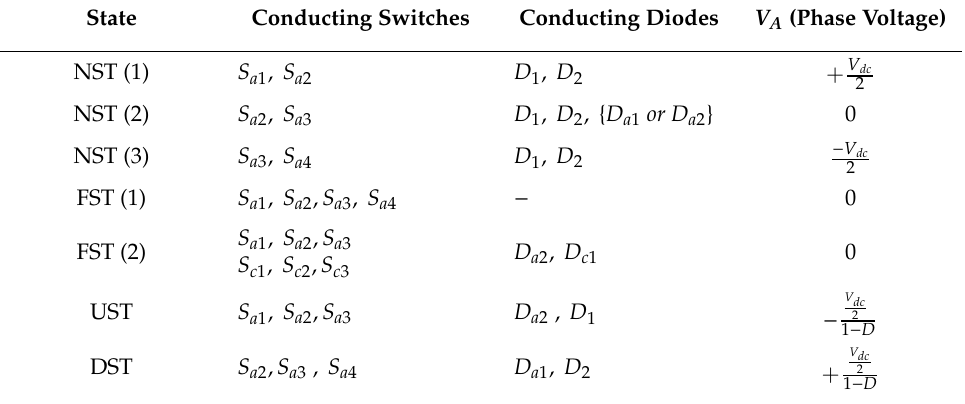
Table 1. Switching states and output values, summarized only for phase A.